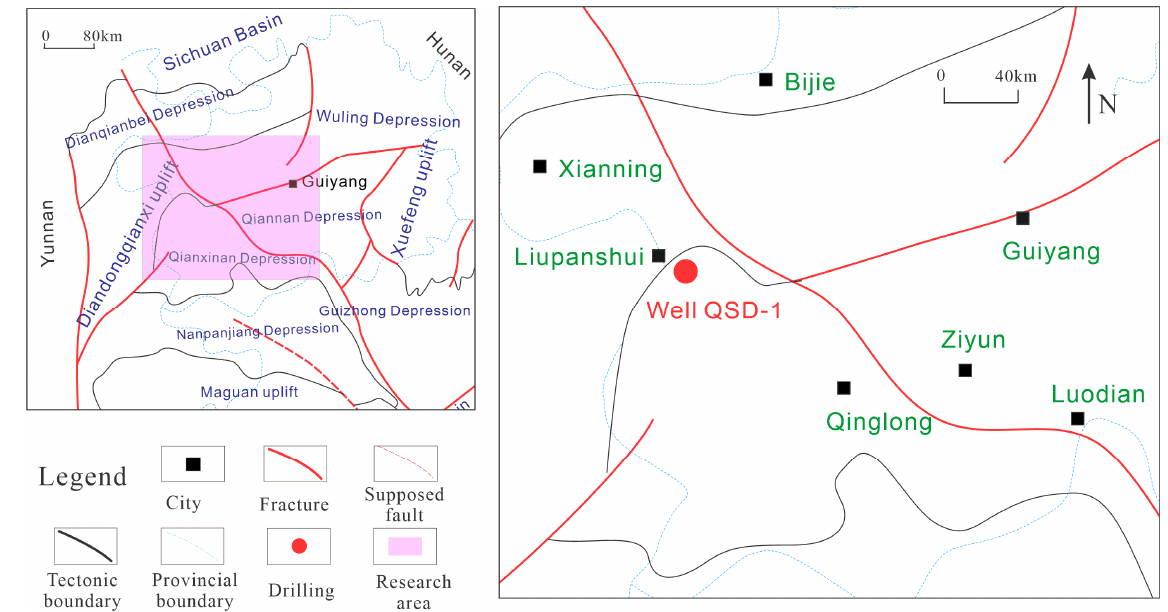
Figure 1. Study area and well location of Qianshuidi 1.